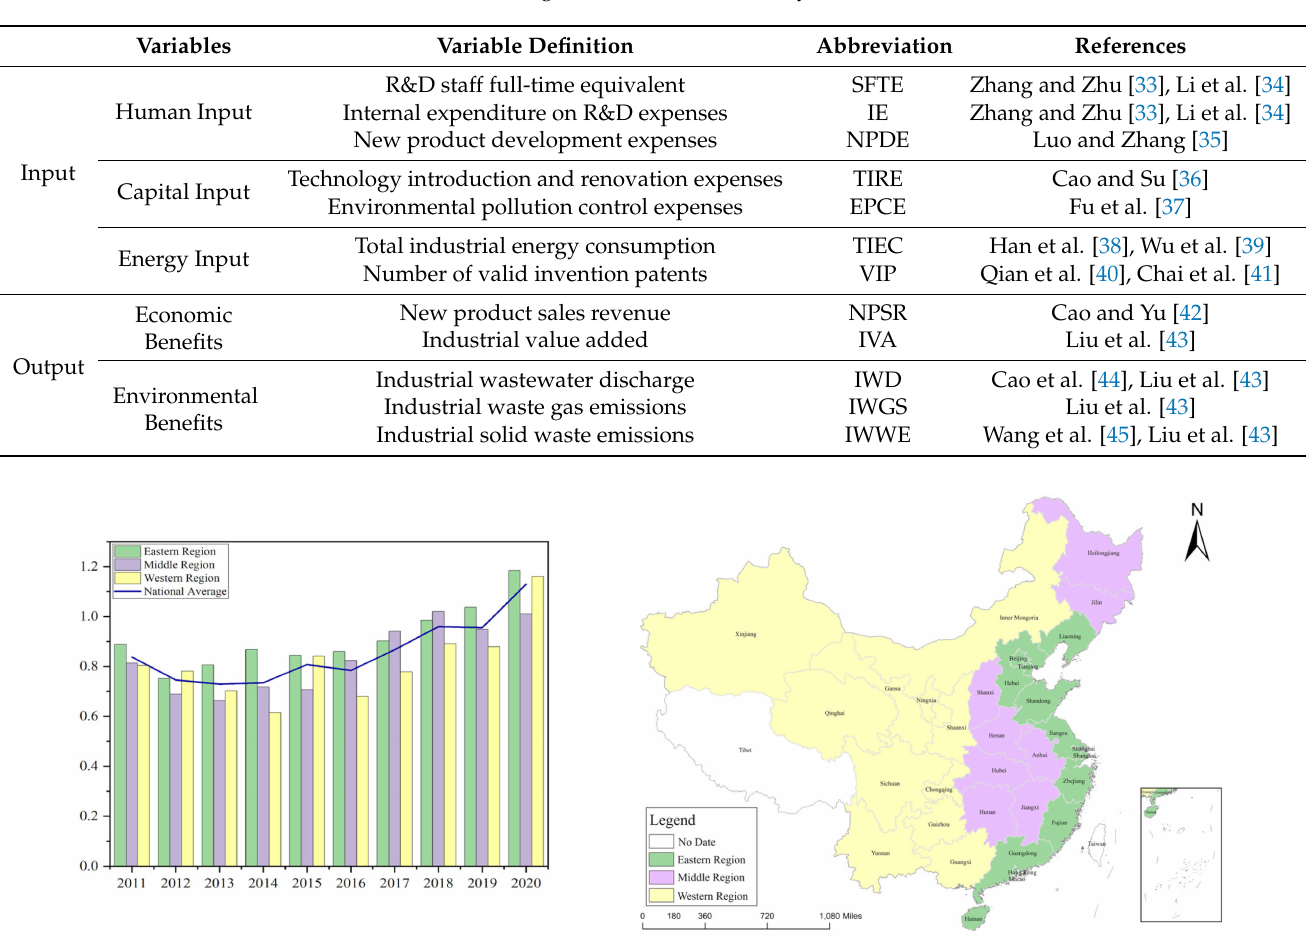
Table 1. Definition of green innovation efficiency variables.